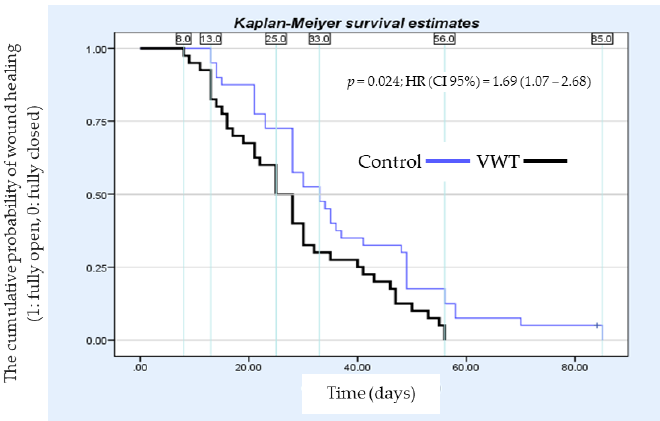
Figure 4. Average wound healing rate for each group and Wagner grade. Table 4. Wound closure area between groups.